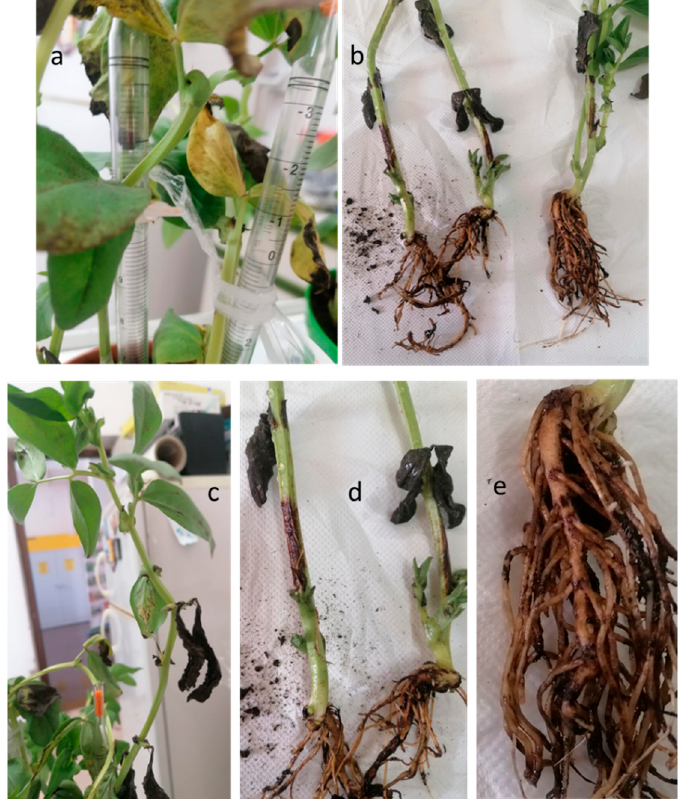
Figure 6 . Symptoms on broad bean plants inoculated with S. sclerotiorum CREA OF 1113.1 twenty days post inoculation. ( a ) Chlorotic leaves; ( b ) stem rot spread from the inoculation point; ( c ) necrosis and desiccation; ( d ) detailed view of stem rot; ( e ) details of root rot.